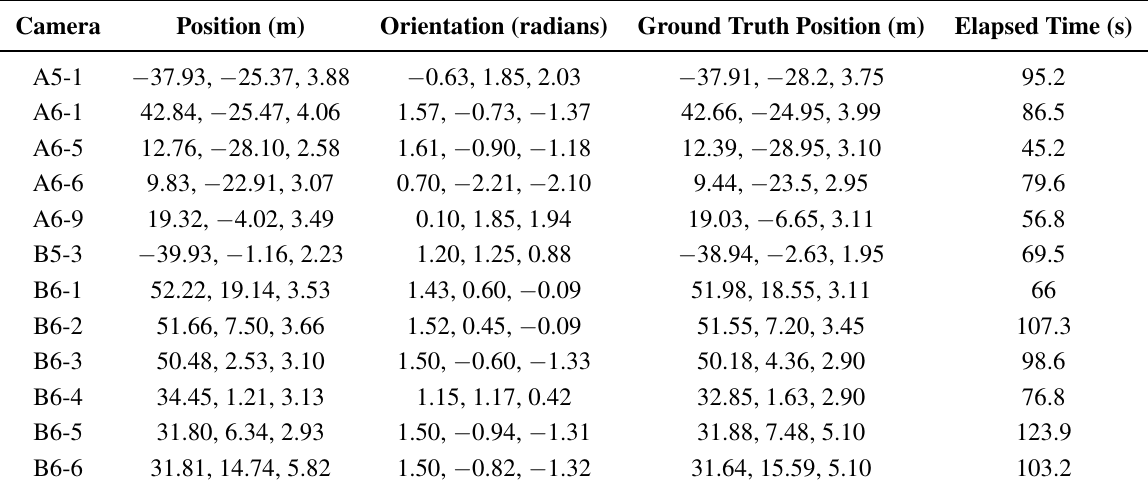
Table 2. Estimated external camera parameters of the BRL scenario.